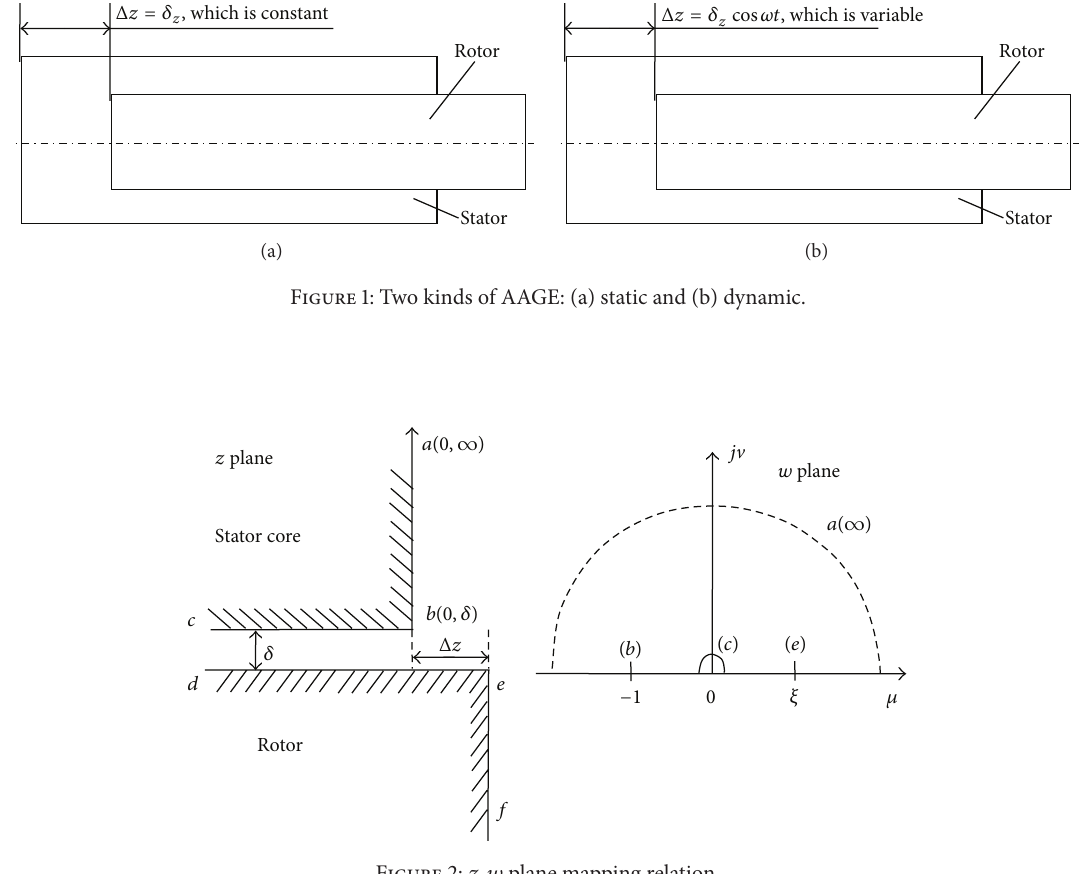
Figure 2: 𝑧 - 𝑤 plane mapping relation.